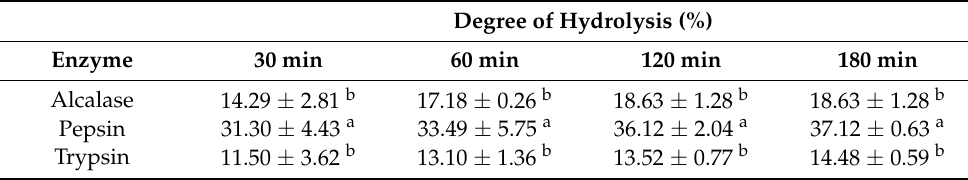
Table 2. Degree of hydrolysis (%) of alcalase, pepsin, and trypsin at 30, 60, 120, and 180